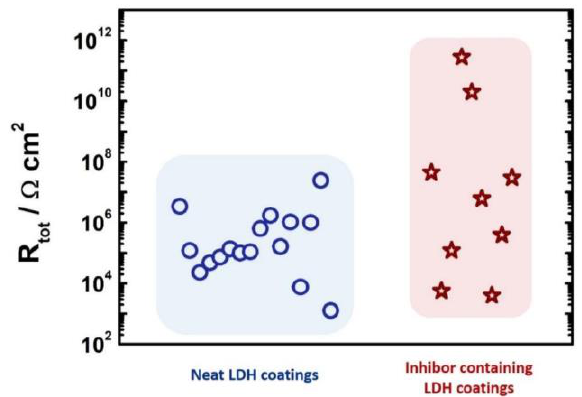
Figure 6. Comparison of the total resistance obtained from EIS spectra fitting for neat and inhibitor exchanged LDH coatings; data taken from [102 – 117].